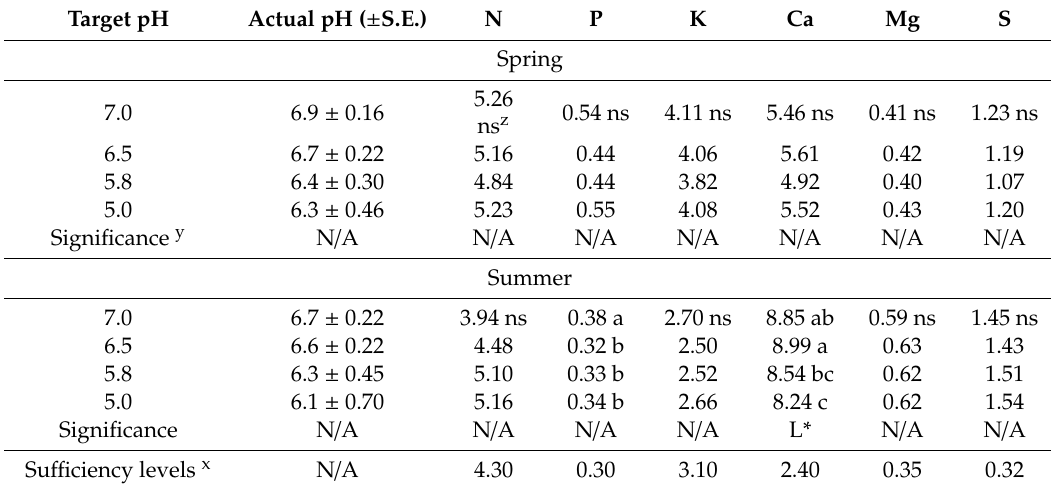
Table 5. End-of-season foliar analysis of macronutrients as percentage of dry matter for aquaponic cucumbers at four target pH